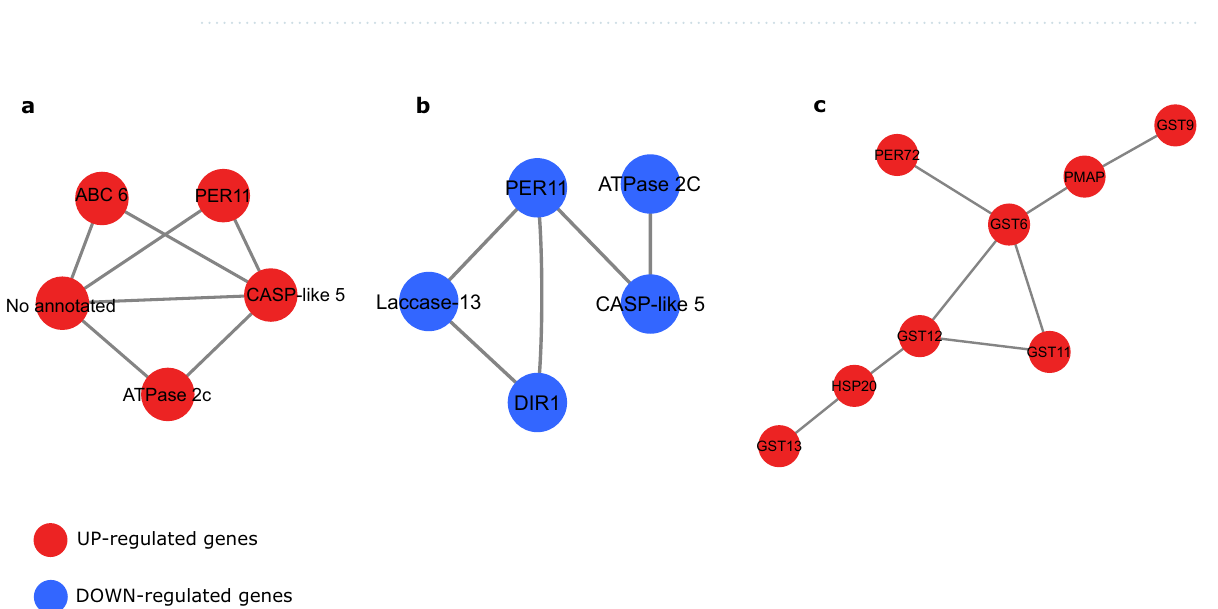
Table 3. Glutathione S-transferases identified in RNA sequencing of Al-sensitive and Al-resistant inbred lines under 72 h of Al stress.